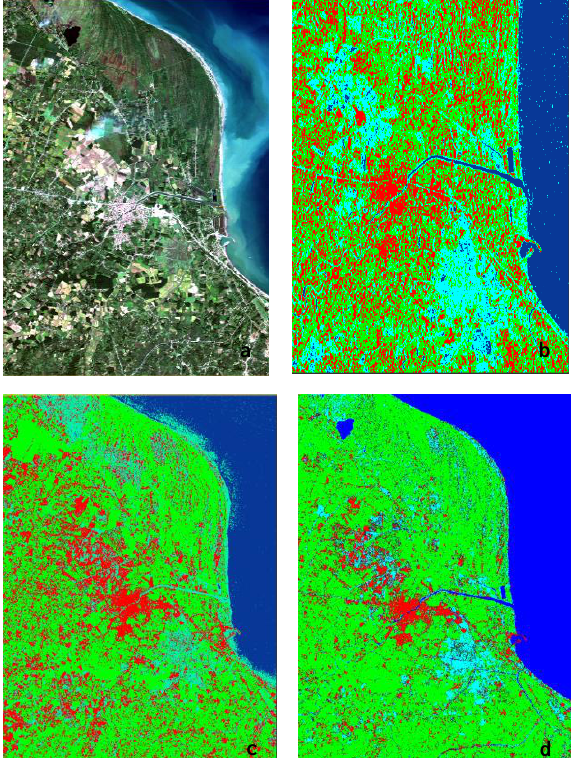
Figure 14. Results of flood analysis produced for the ROI-2 (a: Sentinel-2 MSI image in true colour combination, b: Scenario I classification result, c: Scenario II classification result, d Scenario III classification